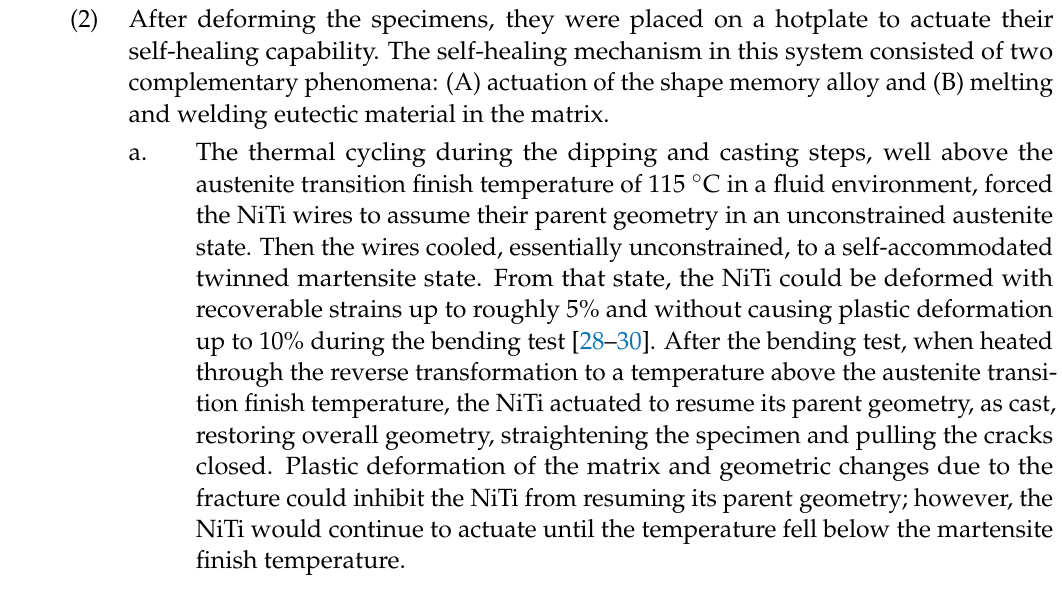
Figure 6. A Sn-Bi specimen with NiTi reinforcement on a 165 °C hotplate undergoing angular recovery. Pictures are at 9 s intervals from the initial motion the point where motion stopped. Reprinted/adapted with permission from Ref. [20]. 2013, Shobhit Misra.